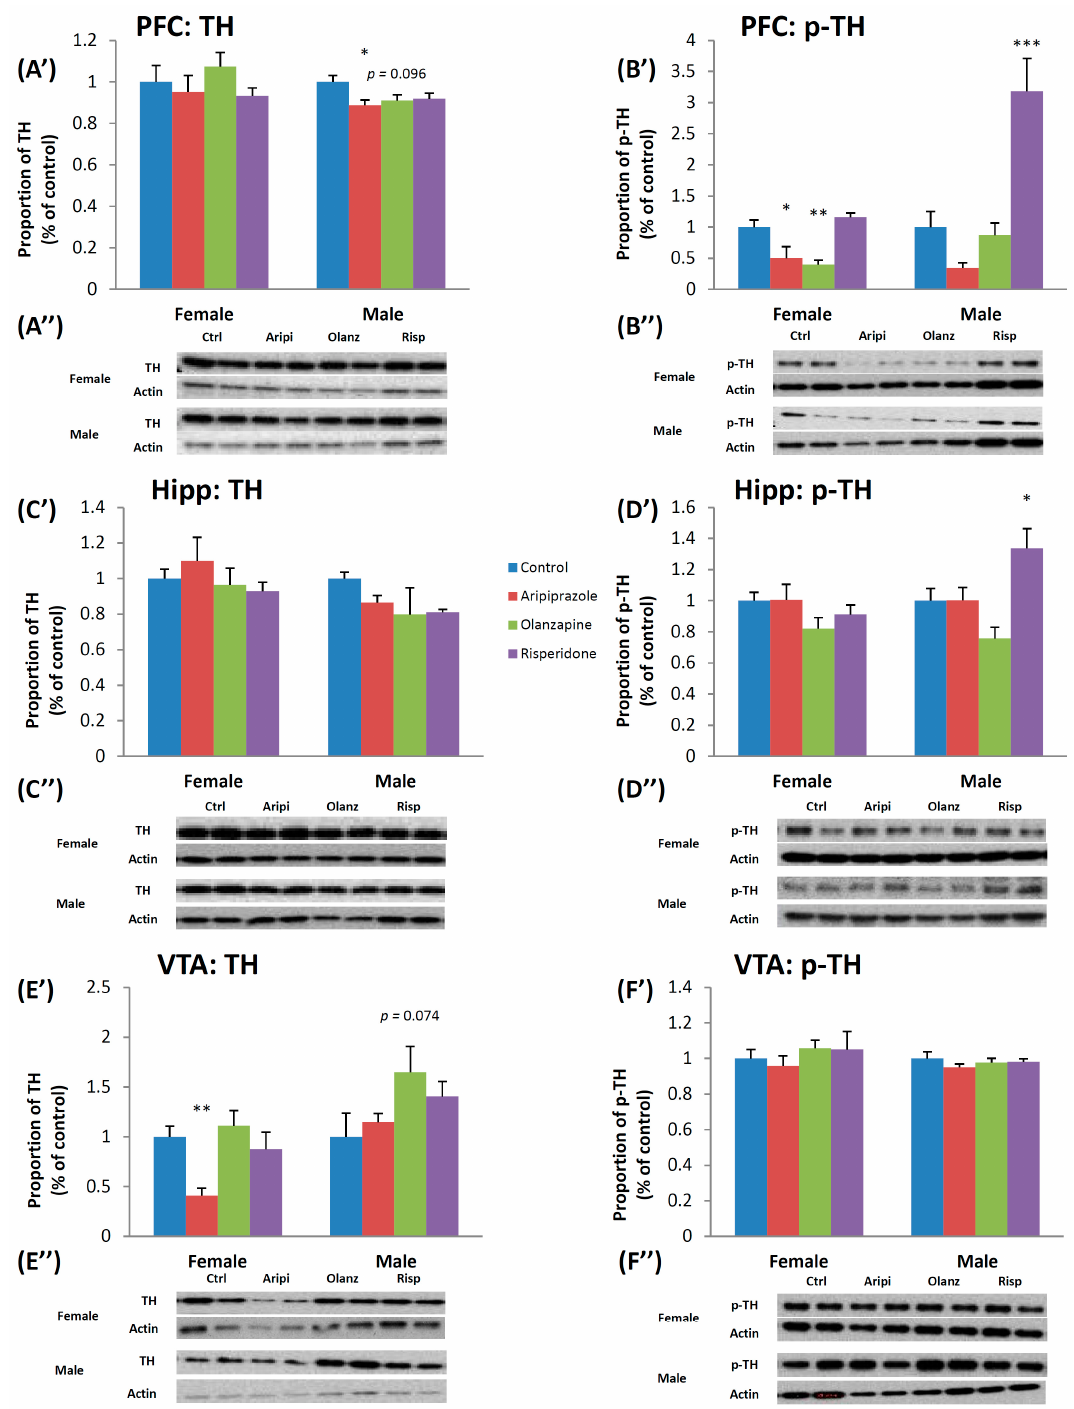
Figure 1. Effects of three APDs on TH and p-TH expression levels in the PFC (TH: ( A’ , A” ); p-TH: ( B’ , B” )), Hipp (TH: ( C’ , C” ); p-TH: ( D’ , D” )) and VTA (TH: ( E’ , E” ); p-TH: ( F’ , F” )) of female and male rats. Sprague-Dawley rats were treated chronically with Aripiprazole (1.0 mg/kg, t.i.d), Olanzapine (1.0 mg/kg, t.i.d), Risperidone (0.3 mg/kg, t.i.d) or control (vehicle). Data expressed as mean ± SEM. * p < 0.05, ** p < 0.01, *** p < 0.001 vs. control. The representative bands of Western Blot are shown. APD: Antipsychotic drug; Hipp: Hippocampus; p-TH: Phosphorylated-tyrosine hydroxylase; PFC: Prefrontal cortex; t.i.d.: Three times daily; TH: Tyrosine hydroxylase; VTA: Ventral Tegmental Area.